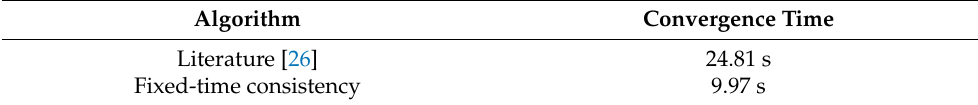
Table 6. Demand load PD = 500 MW, Total iteration time t = 50 s.